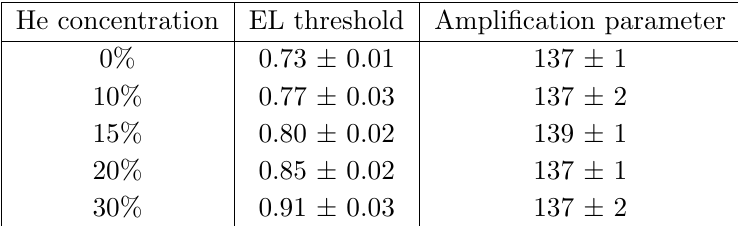
Figure 7 . Electron drift times as a function of voltage di(cid:11)erences applied to the drift region, for pure xenon and Xe-30% He.